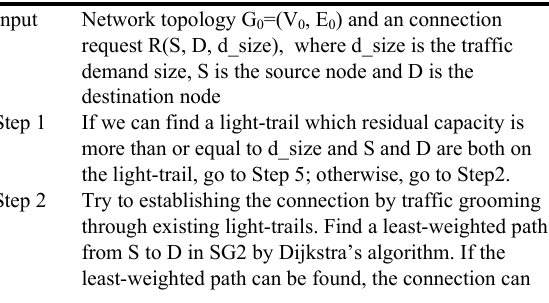
Fig. 3 The node architecture for traffic grooming 19